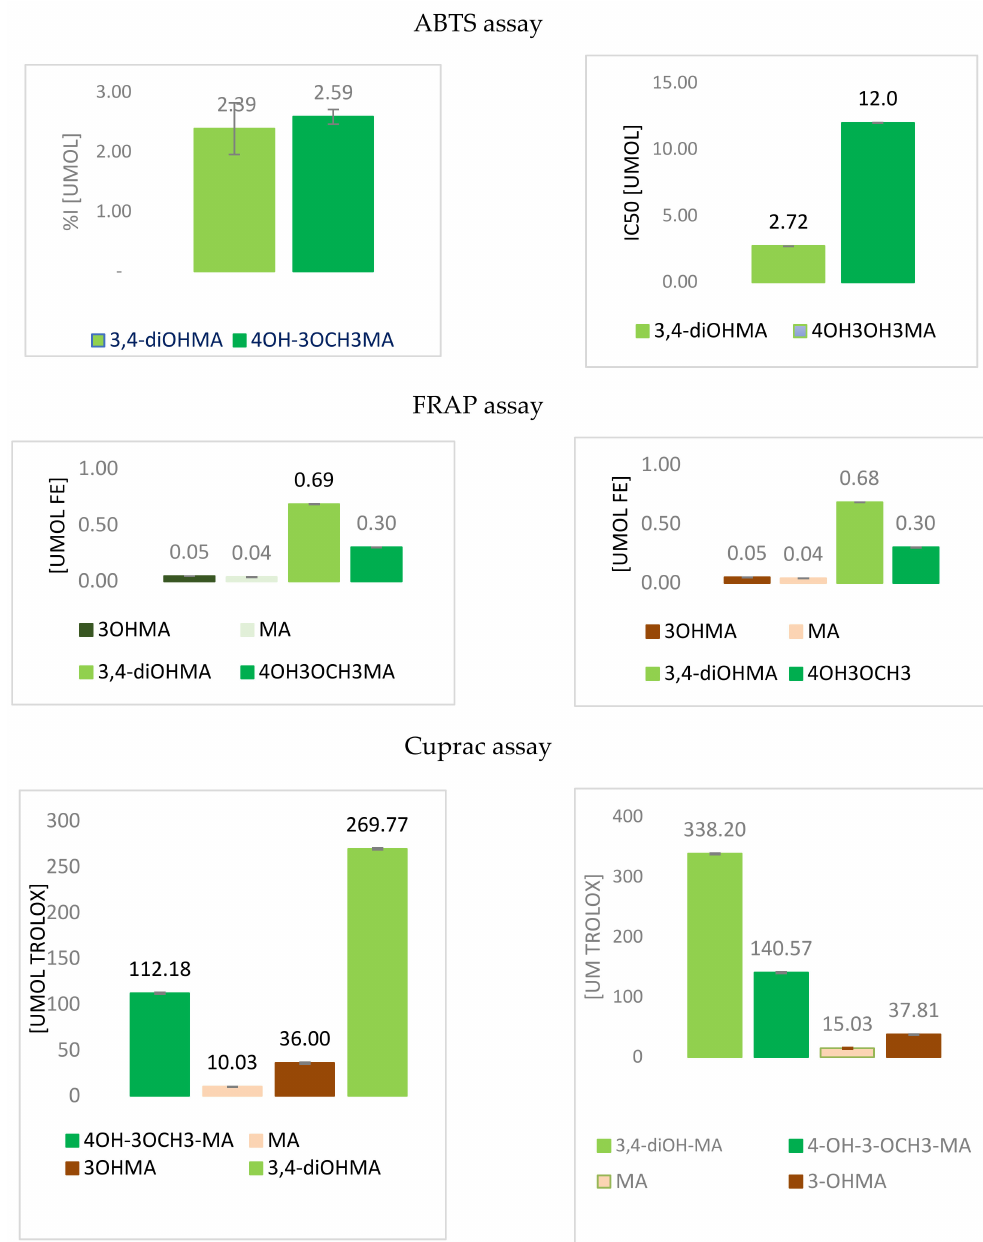
Figure 2. Comparison of antioxidant activities of mandelic acid and its derivatives in water in ethanolic solutions using DPPH, ABTS, FRAP and CUPRAC